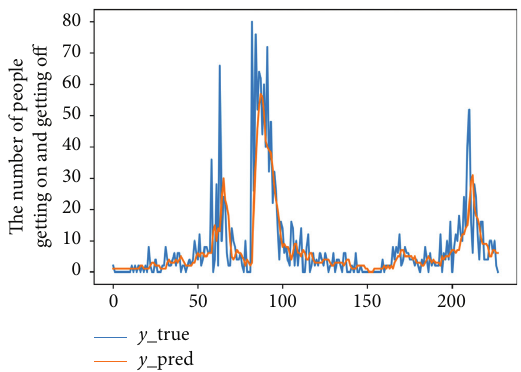
Figure 21: Regression integration prediction results when the time step is 30min.